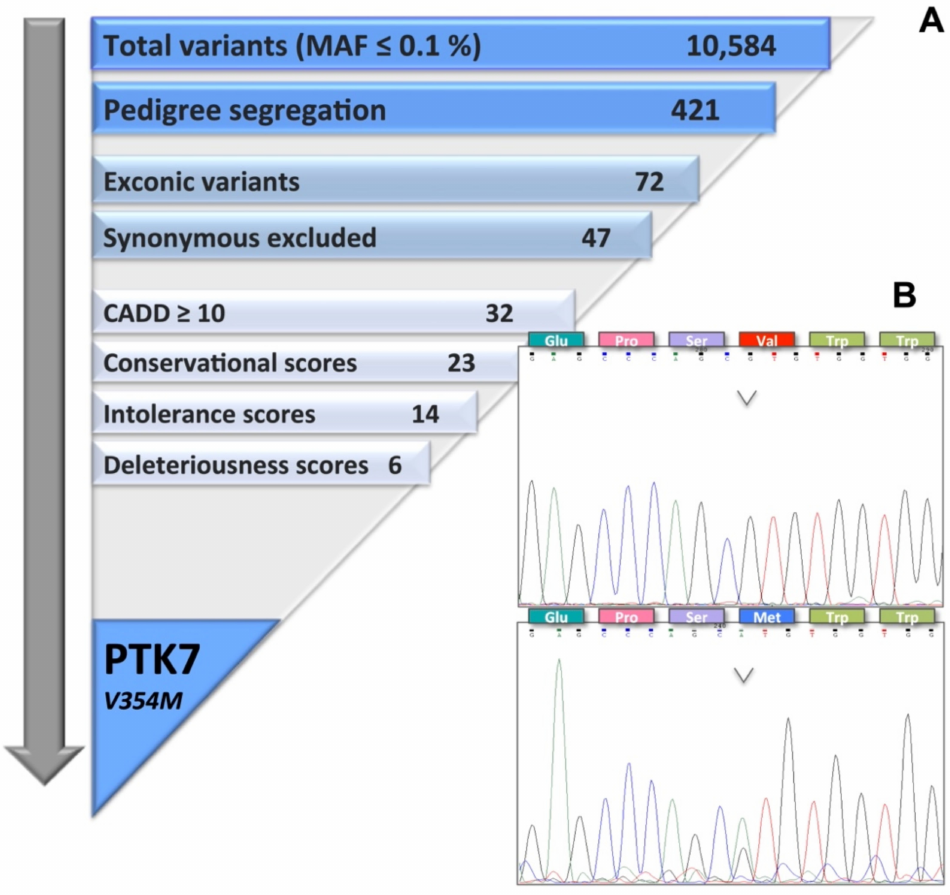
Figure 1. Prioritization of the missense variant V354M in the PTK7 gene. ( A ) Flow chart displaying the filtering process of exonic variants according to the FCVPPv2. Out of 10,584 identified variants, the missense variant V354M in PTK7 gene was prioritized. CADD – combined annotation-dependent depletion tool . ( B ) Electropherograms representing the wild type PTK7 sequence (upper panel) identified in family members II-6 and III-2 and the heterozygous PTK7 V354M variant (lower panel) identified in family members I-2, II-1, II-2, and II-4. The respective substitution Val → Met is displayed in the amino acid sequences. The color of curves indicates the detected nucleobases: black stands for guanine, green for adenine, blue for cytosine, and red for thymine. Glu – glutamic acid , Pro – proline , Ser — serine , Val — valine , Trp — tryptophan , Met — methionine